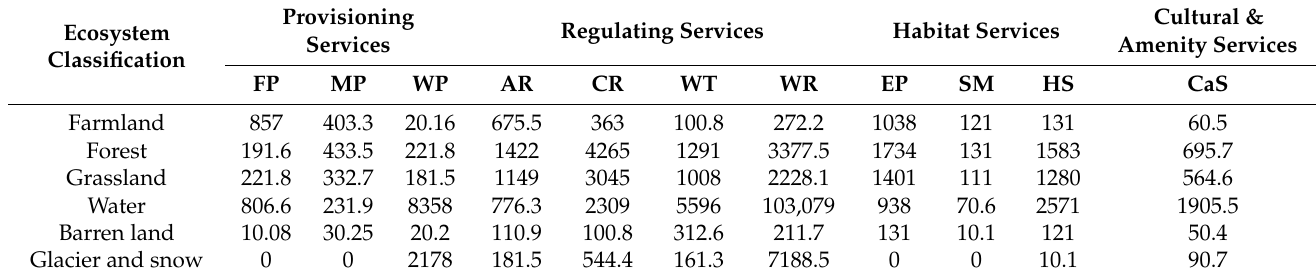
Table 1. Ecosystem service equivalent value per unit area of Qinghai